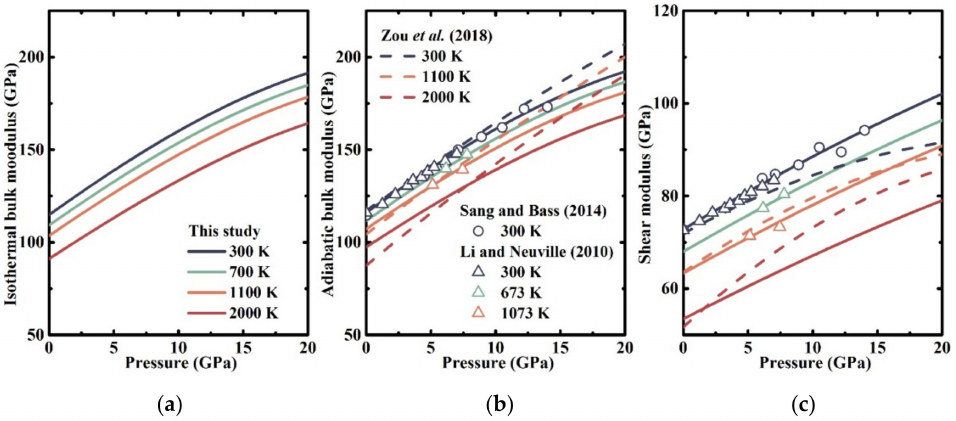
Figure 2. Elastic moduli of diopside as a function of pressure at various temperatures. Solid lines refer to our calculated results and dashed lines refer to the first-principle calculation results from Zou et al. (2018) [24]. The circles and triangles represent the results from Sang and Bass (2014) [37] and Li and Neuville (2010) [23], respectively. ( a ) Isothermal bulk modulus ( b ) Adiabatic bulk modulus ( c ) Shear